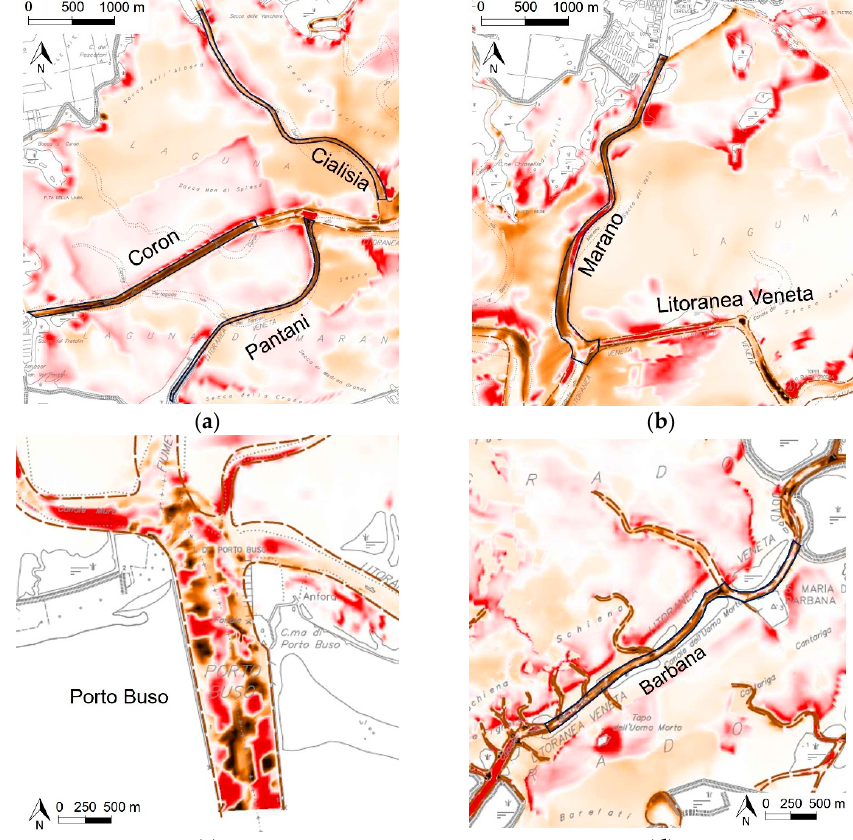
Figure 12. Details of some channels of Figure 11: ( a ) Pantani, Coron and Cialisia; ( b ) Marano and Litoranea Veneta; ( c ) Porto Buso; ( d ) Barbana. The dashed lines represent the edge of the channels, solid lines identify the critical branches that really require ordinary annual dredging intervention. The contour legend is the same as Figure 11.